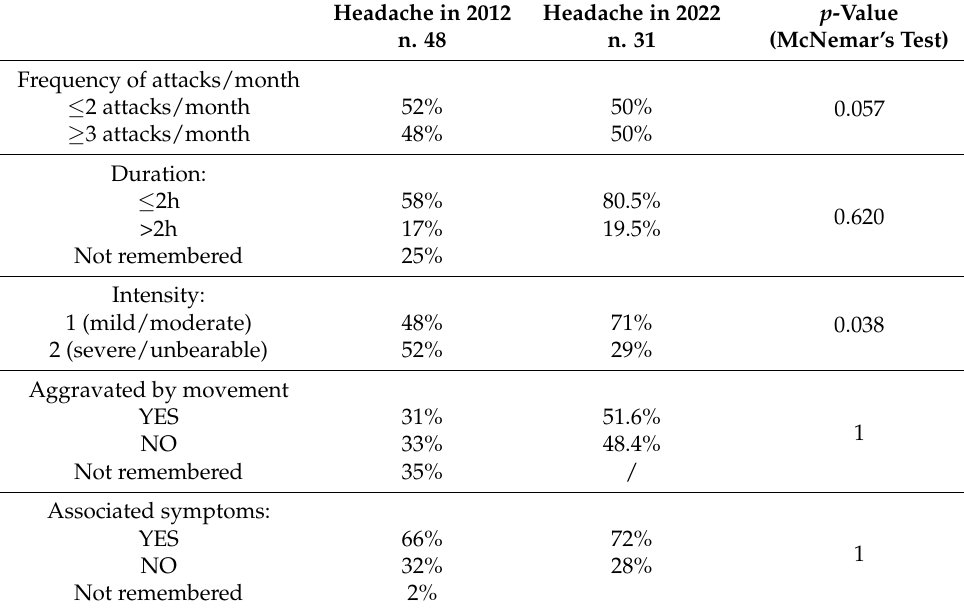
Table 2. Comparison between migraine features of the sample in 2012 and 2022.